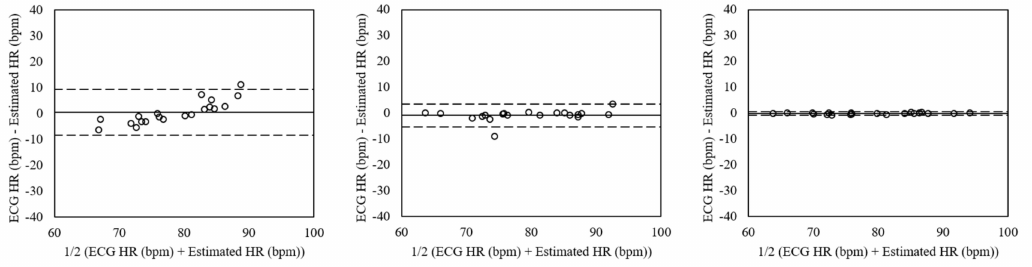
Figure 9. Bland–Altman plots of heart rates estimated from the normal dataset without facial expressions and voluntary head motions using peak detection ( Left ), FFT ( Mid ), and clustering ( Right ). The lines are the mean errors and 95%